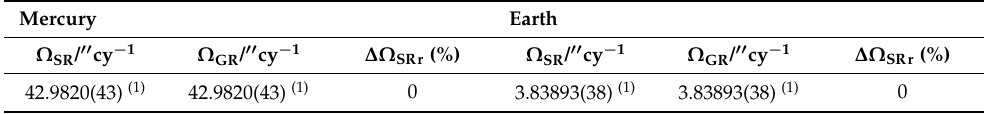
Table 1. Angular velocity of perihelion rotation (“precession”) for Mercury and Earth according to the gravitational field of the SR Schwarzschild Generalized Potential ( Ω SR ) and the Schwarzschild metric ( Ω GR ), respectively. ∆Ω SRr (%) is the percentile relative